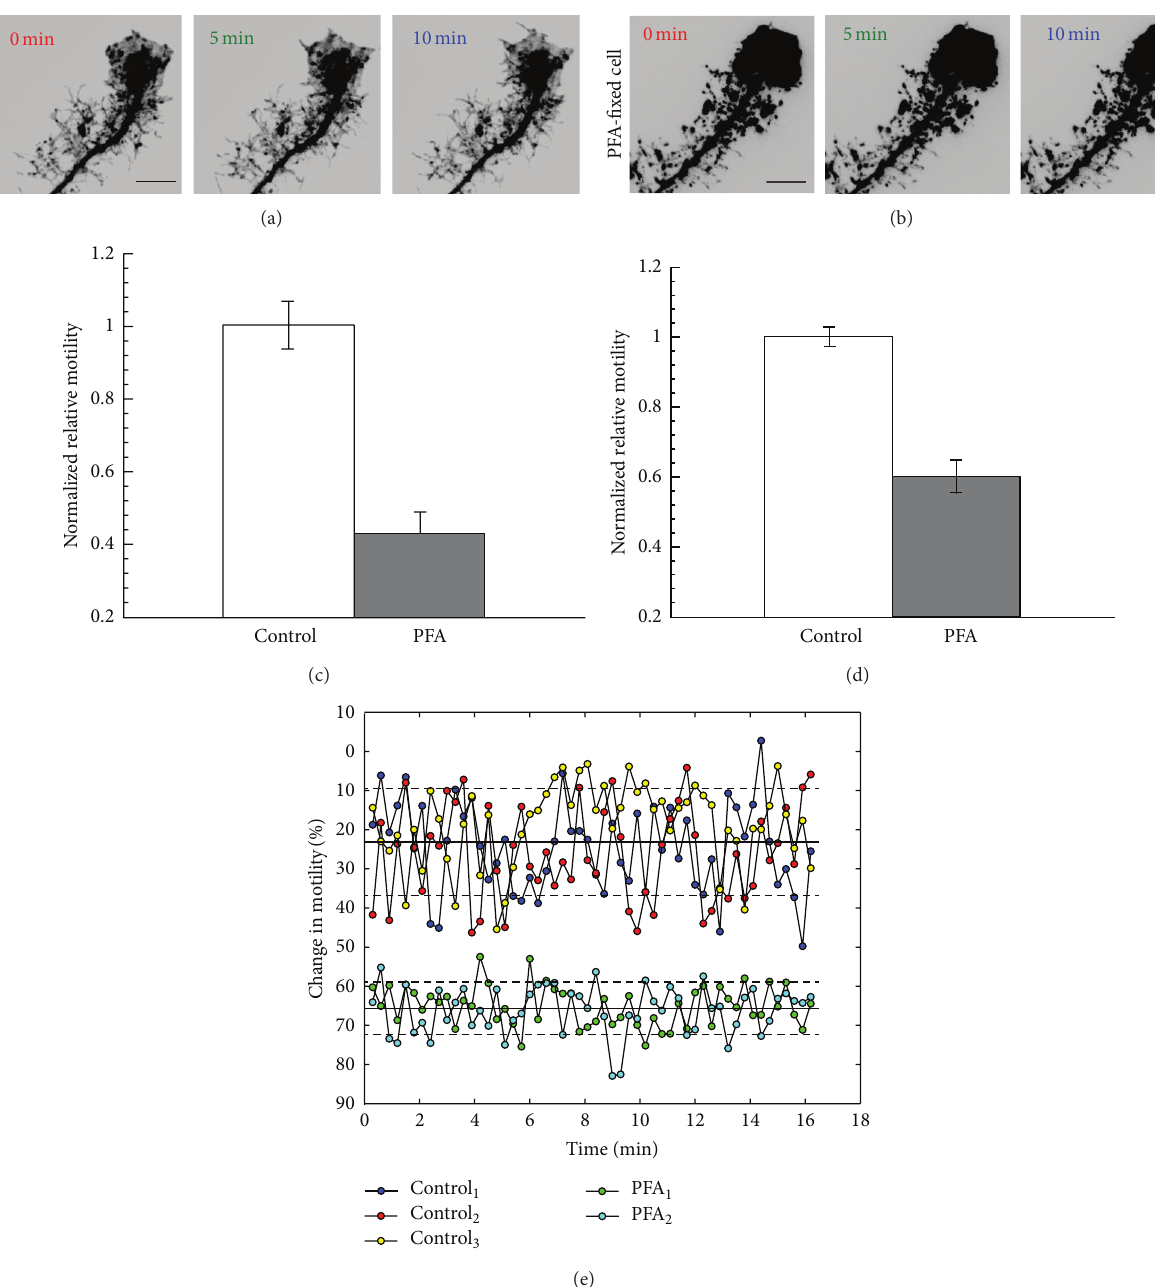
Figure 6: Use of paraformaldehyde- (PFA-) fixed cells to reveal nonbiological artifacts that contribute to the motility index scores. (a) The motility of control living cells ( 𝑁 = 4 ) was compared with (b) dead cells fixed in paraformaldehyde ( 𝑁 = 5 ). ((c), (d)) Bars indicate the motility values of the two groups normalized to the mean of control values using Method 1 in (c) and Method 2 in (d). Error bars are SEM. (e) Applying a low-pass temporal frequency filter with a threshold of 0.0026 Hz (6.4min period) reduces the motility index scores (measured using Method 2) of the PFA-fixed cell group by substantially more than the control group, indicating that the filter is effective at eliminating nonbiological noise. Dashed lines indicate full width at half maximum. Scale bars = 10 𝜇